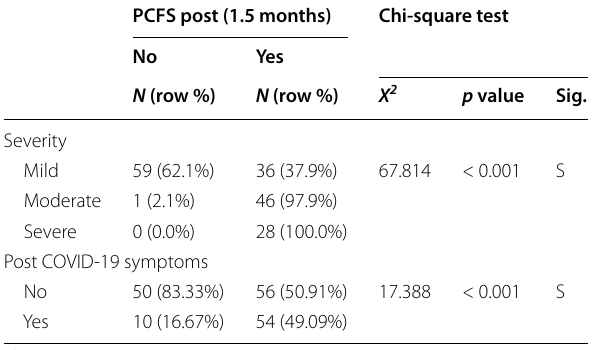
X 2 chi square test value, statistical significance at p